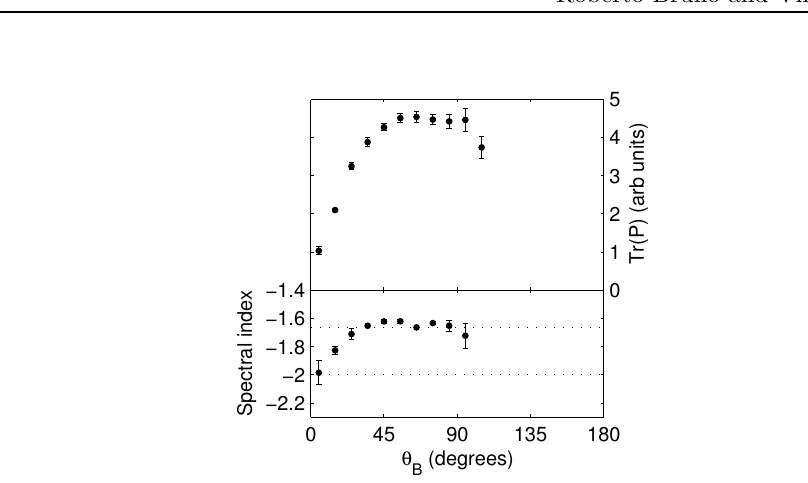
Figure 24: Top panel: Trace of power in the magnetic field as a function of the angle between the local magnetic field and the sampling direction at a spacecraft frequency of 61 mHz. The larger scatter for 𝜃 𝐵 > 90 is the result of fewer data points at these angles. Bottom panel: spectral index of the trace, fitted over spacecraft frequencies from 15.98 mHz. Image reproduced by permission from Horbury et al. (2008), copyright by